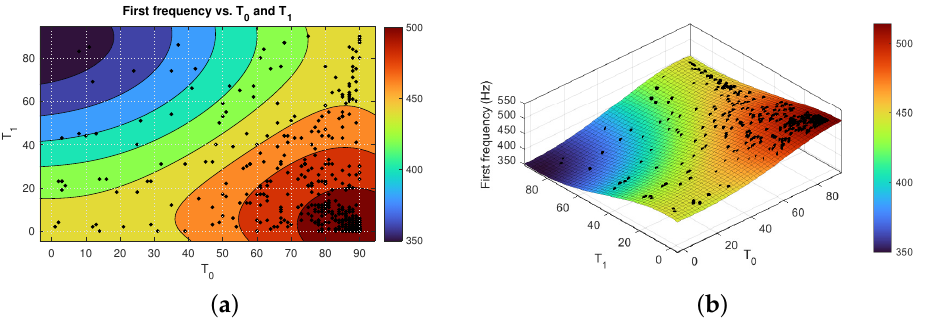
Figure 16. During implementation of the GA technique in a free vibration issue, the contour plot and response surface reveal the impacts of variables (fiber orientation angles). ( a ) Colors represent the f 1 in this contour plot of variables. ( b ) Response